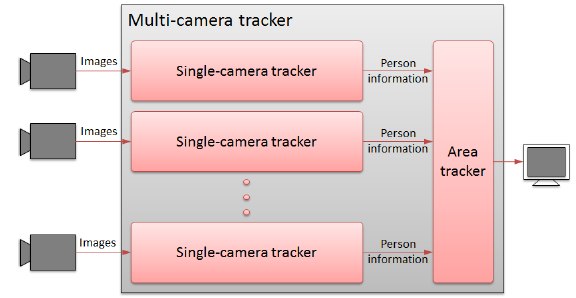
Figure 1: General design of our tracking system.